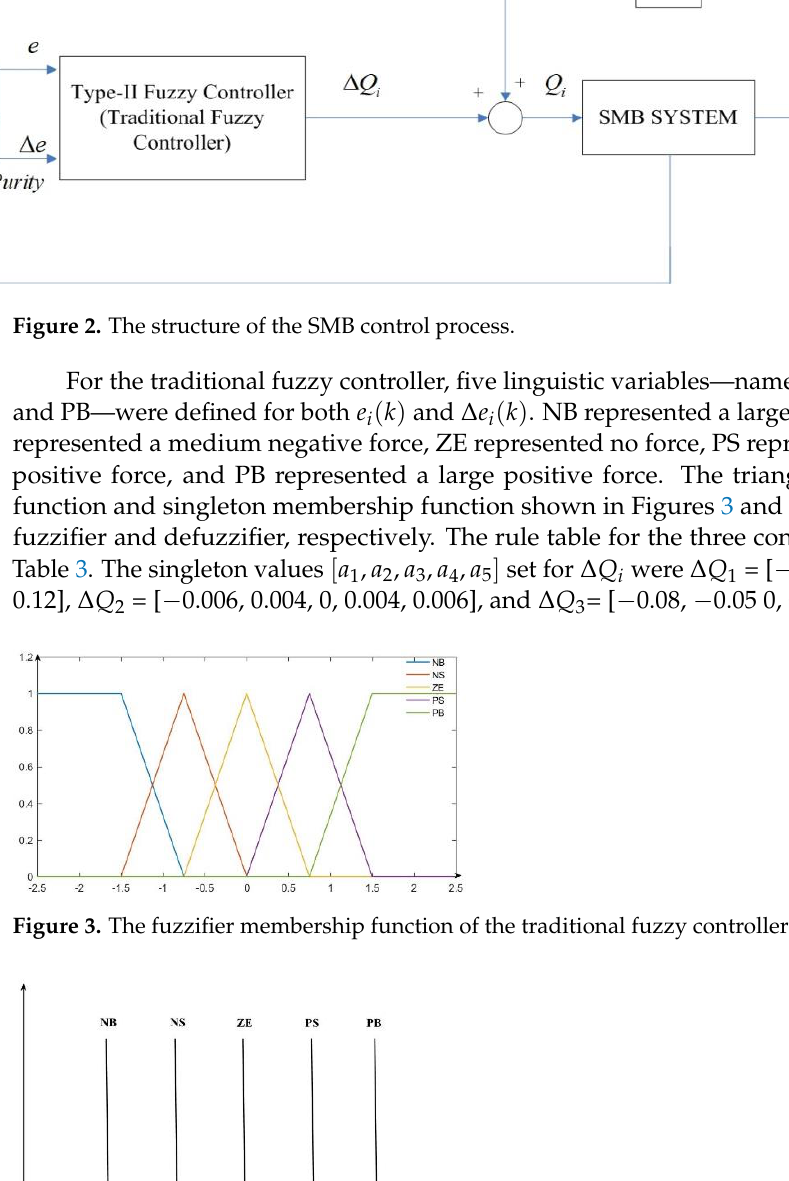
where e 1 ( k ) and ∆ e 1 ( k ) were the inputs of the zone I controller, e 2 ( k ) and ∆ e 2 ( k ) were the inputs of the zone II controller, and e 3 ( k ) and ∆ e 3 ( k ) were the inputs of the zone III controller. In the control process of the SMB, the flow rates of zone I ( Q 1 ), zone II ( Q 2 ), and zone III ( Q 3 ) were controlled by three independent fuzzy controllers. The common structure of the fuzzy control process is shown in Figure 2.